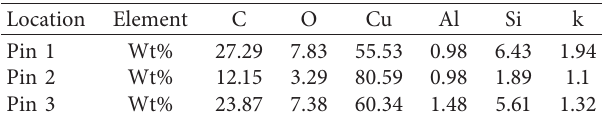
Table 1: EDS test results of three locations of the antishock MOS tube.